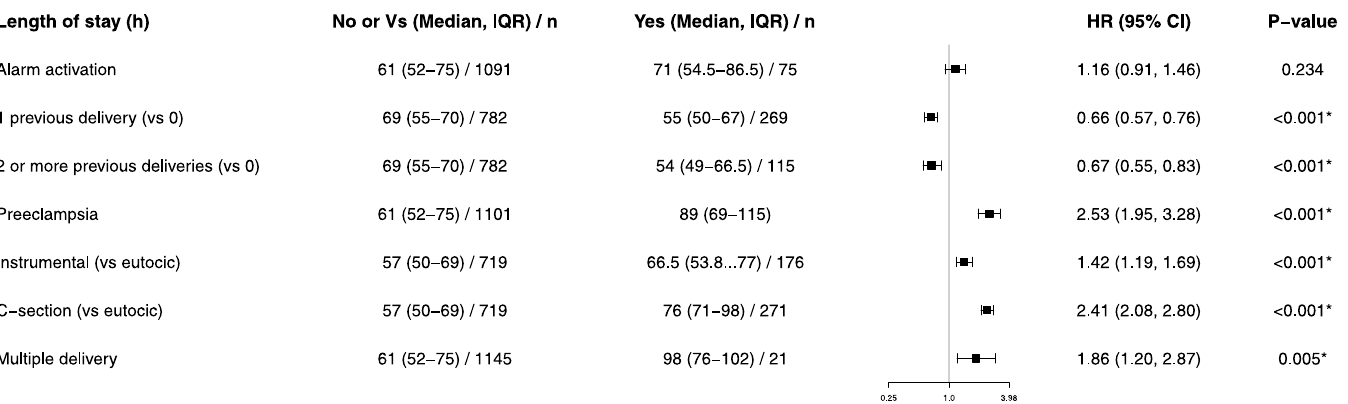
Fig 5. Forest plot of Cox regression of the influence of MEWS activation, patient comorbidity and delivery on length of stay. We present the results as an hazard ratio with a 95% confidence interval. Results less than 1, left of the y-axis, imply risk reduction. We accepted p < 0.05 as significant.